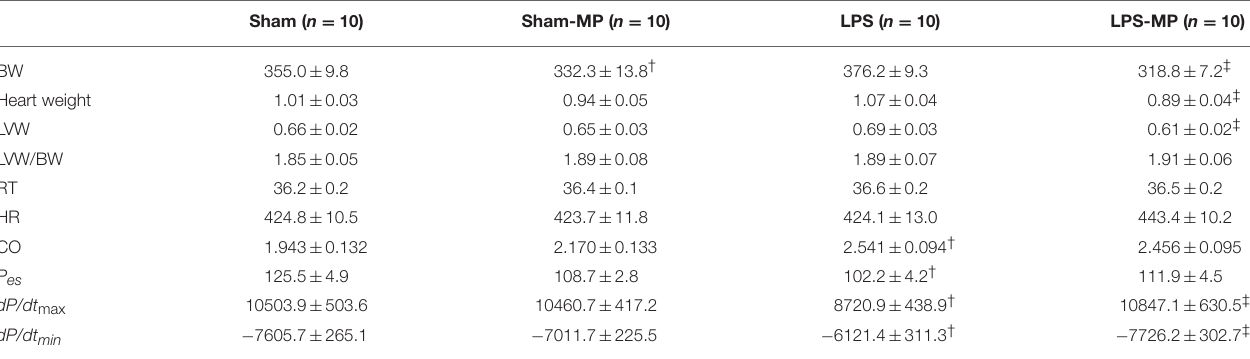
TABLE 1 | Basic and hemodynamic data in the LPS-challenged rats treated with